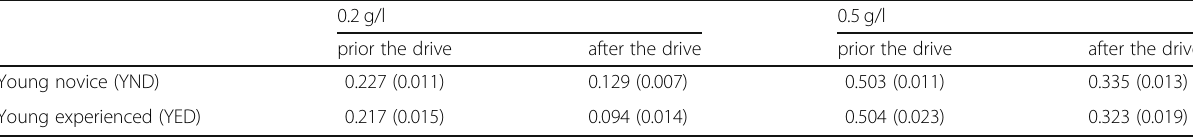
Table 1 Mean BACs measured prior and following the drive as a function of experience (SD between brackets) 0.2